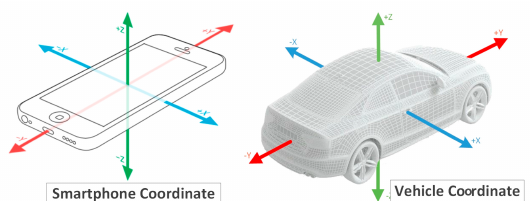
Figure 1. Smartphone and car axes resulting